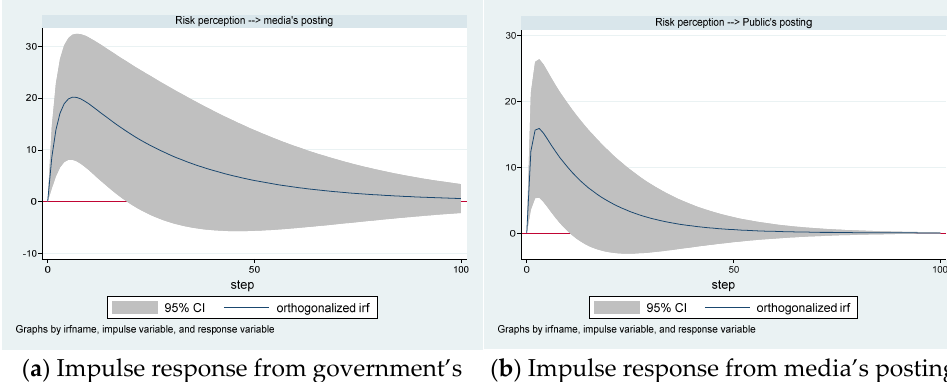
Figure 6. The dynamic effects of risk perception on the postings.